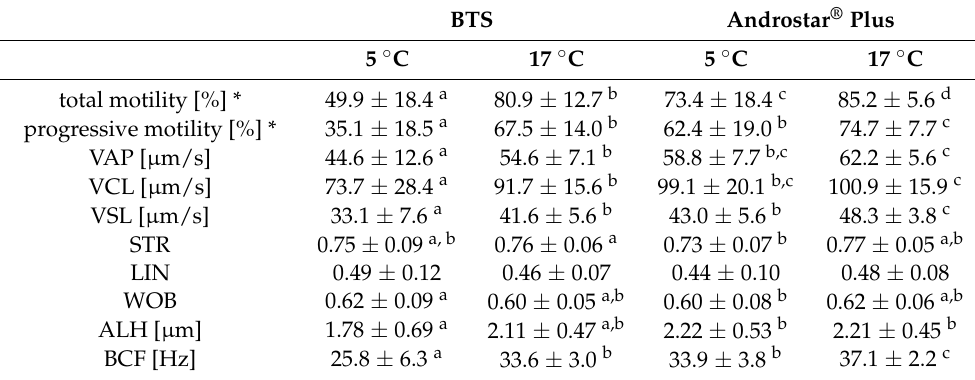
Table 1. Comparison of CASA kinematic parameters for semen samples after 24 h storage in Beltsville Thawing Solution (BTS) or Androstar ® Plus at 17 ◦ C or 5 ◦ C ( n = 7 boars). Different superscripts (a–d) within a row indicate significant differences. Results are based on Student’s t -test for paired samples unless otherwise indicated ( p < 0.05). Data are presented as mean and standard